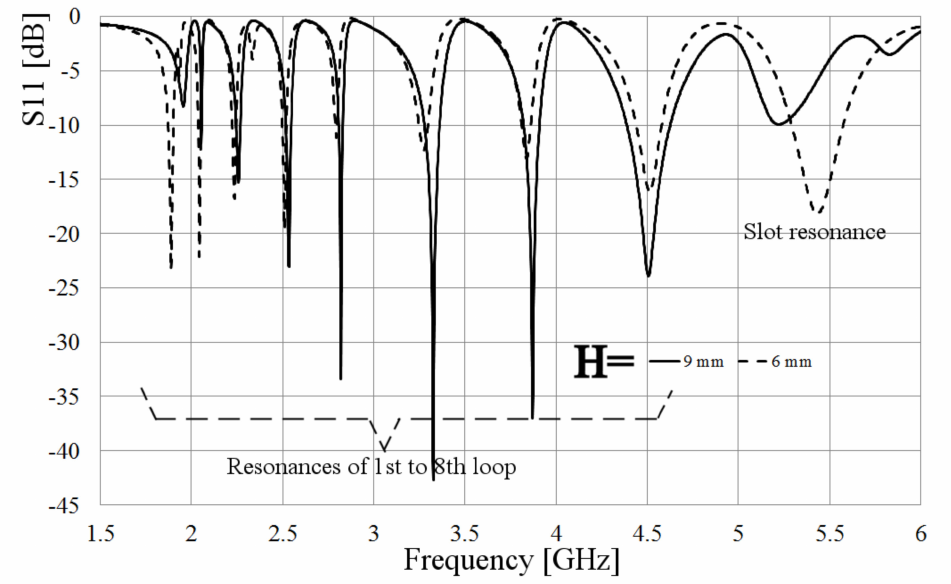
Figure 13. Comparison of simulated S11 parameter of the loop-slot array at different distances between